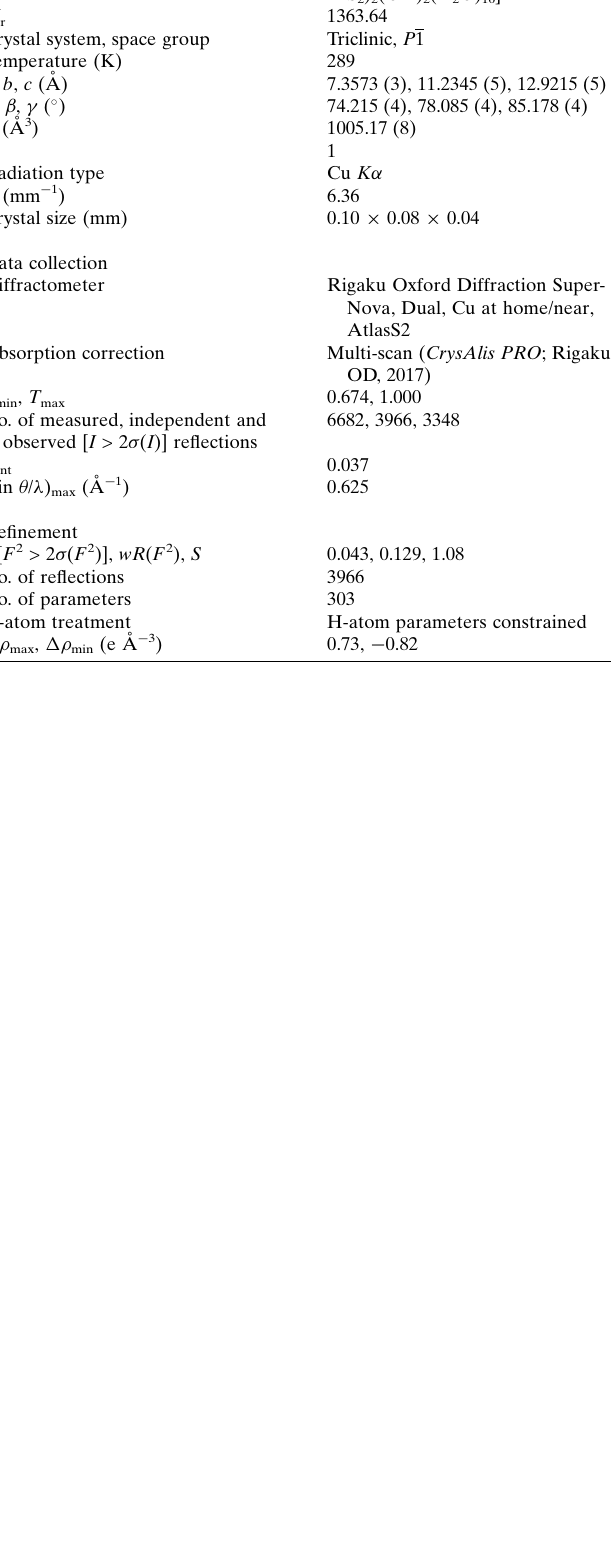
Table 2 Experimental details. Crystal data Chemical